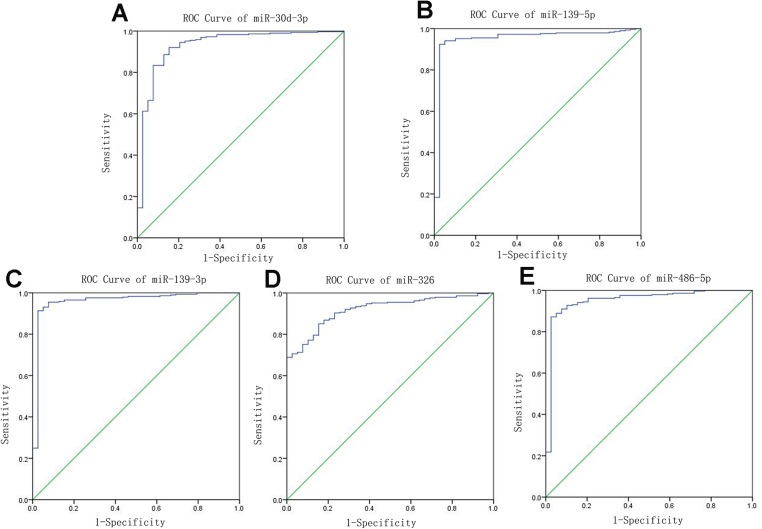
Receiver operating characteristic curve analysis of specific key miRNAs.